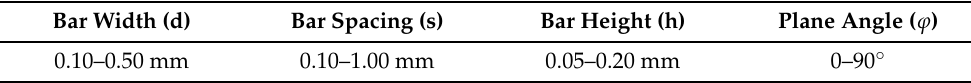
Table 1. Parameter ranges of the design variables for the LHS [36].